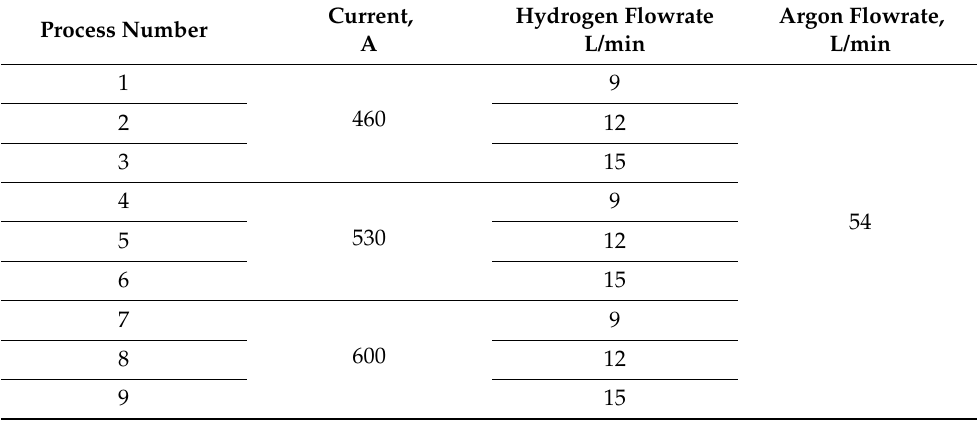
Table 2. The APS process parameters